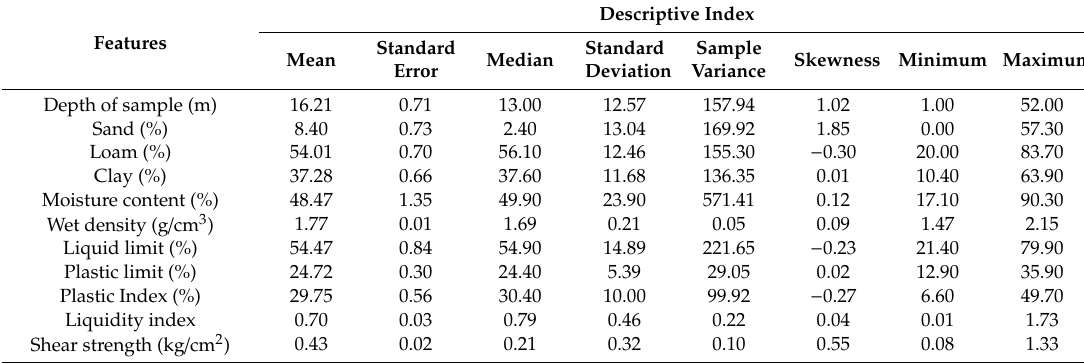
Table 1. Descriptive statistics of the used